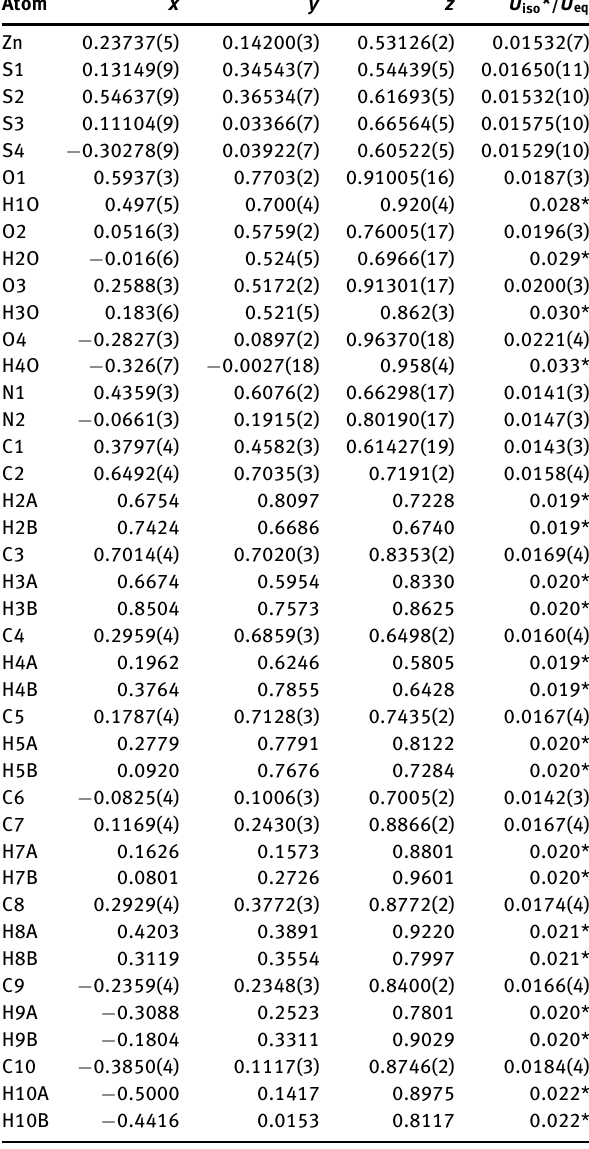
Table 2: Fractional atomic coordinates and isotropic or equivalent isotropic displacement parameters (Å 2